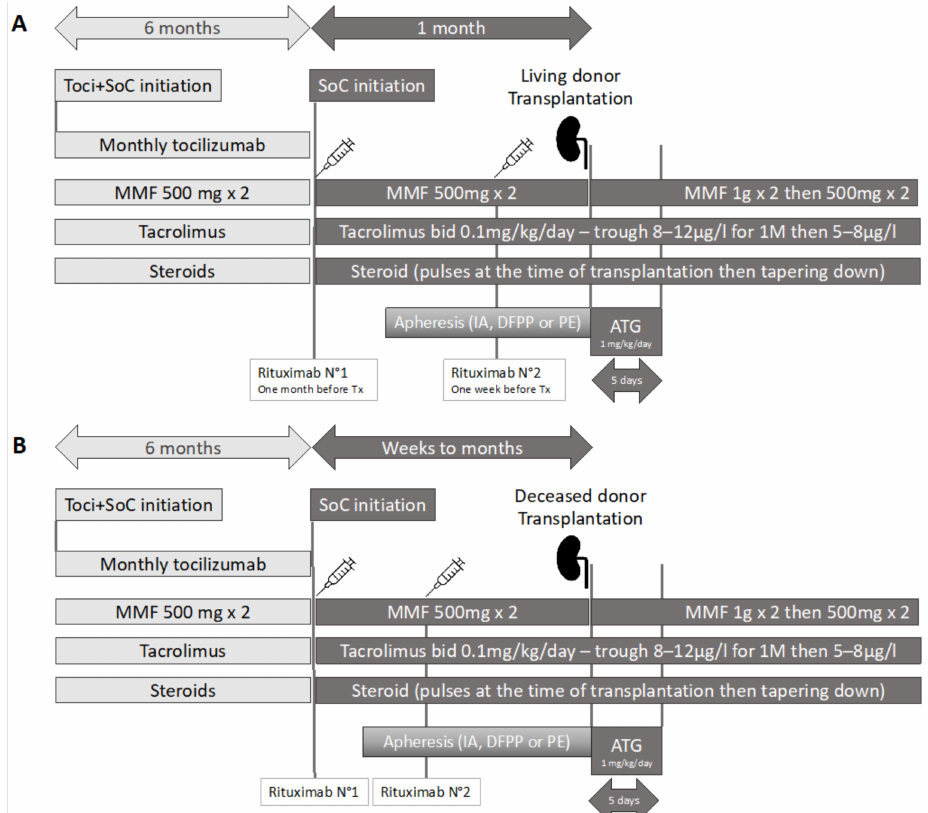
Figure 1. Overview of the desensitization process, ( A ) for the living donor kidney transplantation, ( B ) for deceased donor kidney transplantation. All patients followed the dark gray path; only Toci + SoC patients followed the light gray path before receiving the